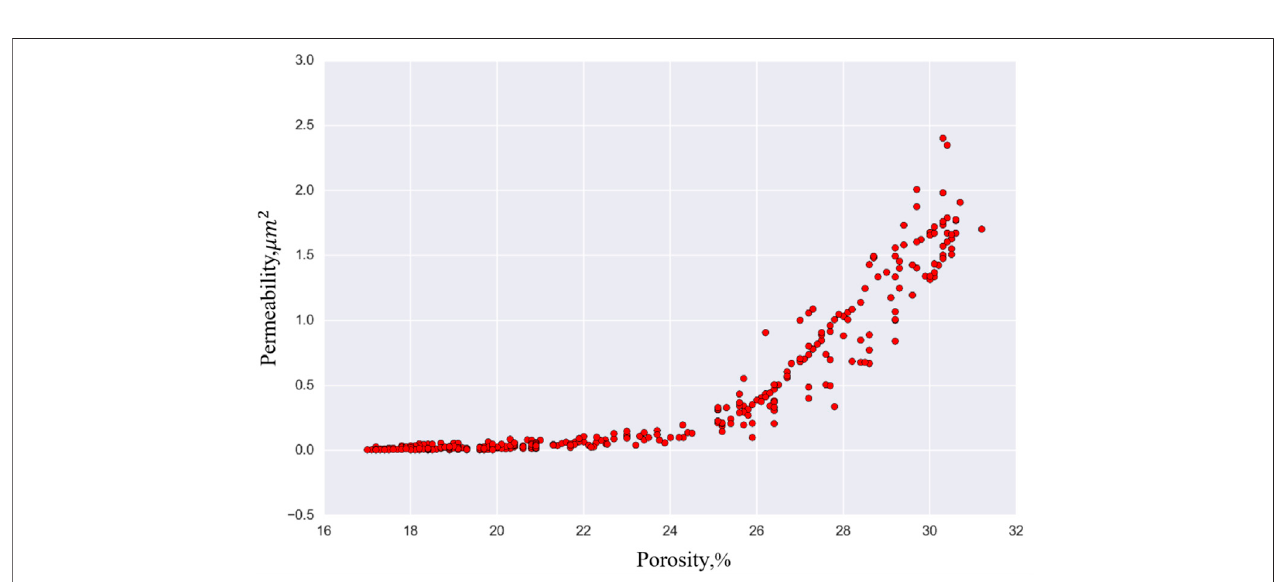
FIGURE 1 | Relationship between porosity and permeability in the study